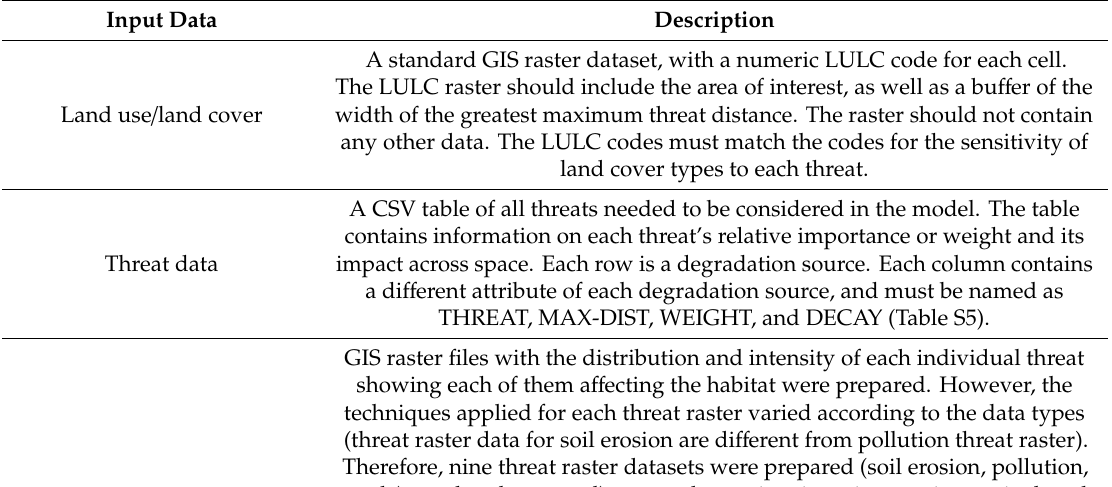
Table 1. Data input for the habitat quality